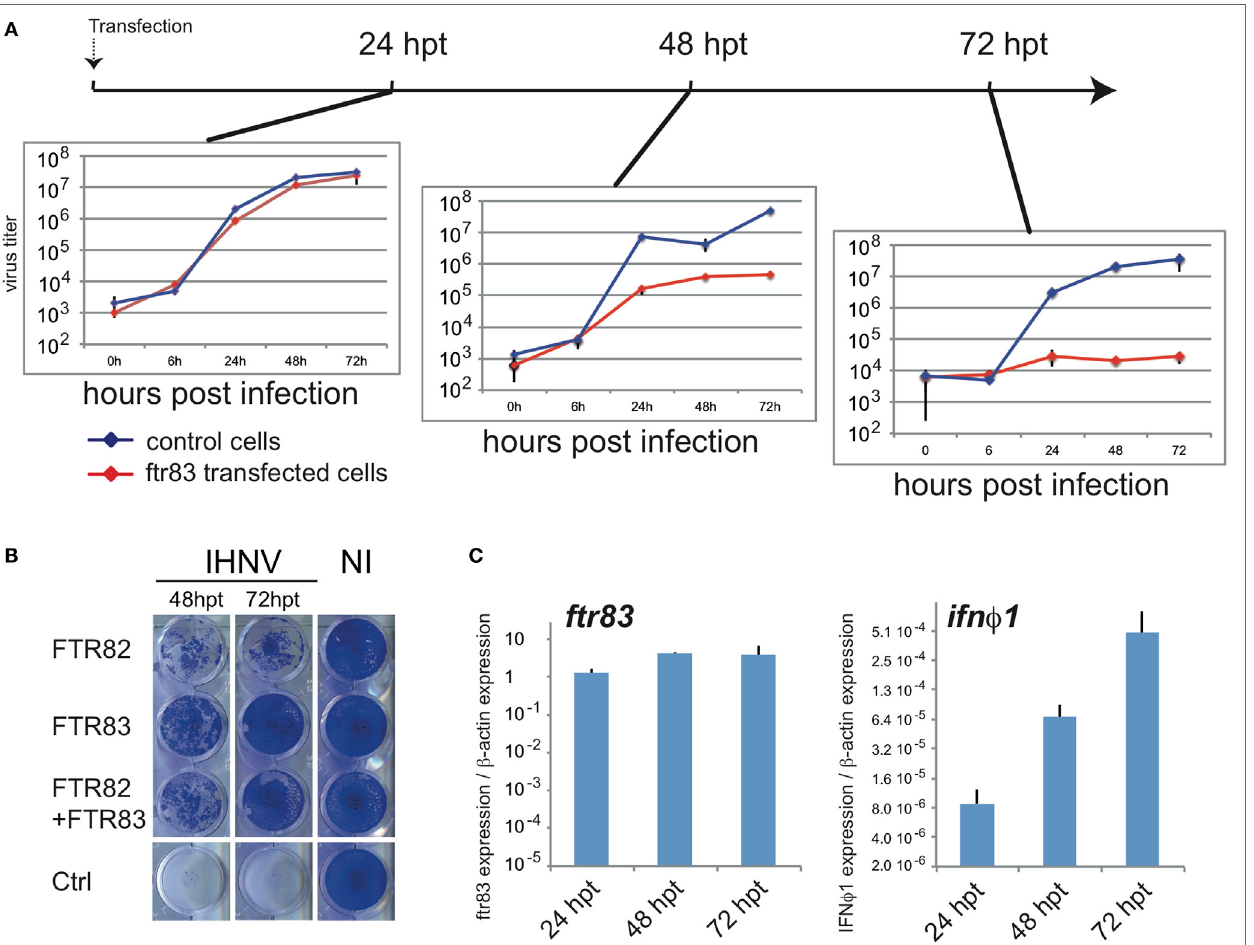
FigUre 4 | antiviral effect of FTr83 is paralleled by stimulation of the type i iFn pathway . (a) Epithelioma papulosum cyprini cells were transfected with ftr83 -encoding or empty plasmid and were infected with IHNV (MOI1) 24, 48, or 72 h post transfection. Kinetic of IHNV growth was measured by viral titration from 0 to 72 hpi. The mean and SD of three replicates are presented. (B) Cytopathic effect of IHNV infections when cells were infected 48 and 72 h post transfection at MOI1. Viral-induced cytopathic effect was assessed by crystal violet staining at 72 hpi. Non-infected cells are presented as a control (NI). (c) ftr83 and ifn ϕ 1 transcripts quantified by RTQPCR at the onset of infection, i.e., 24, 48, or 72 h post transfection. Results were normalized on the β -actin expression: measured ratio of cDNA of interest/ β -actin cDNA is shown. Mean and SD of three independent